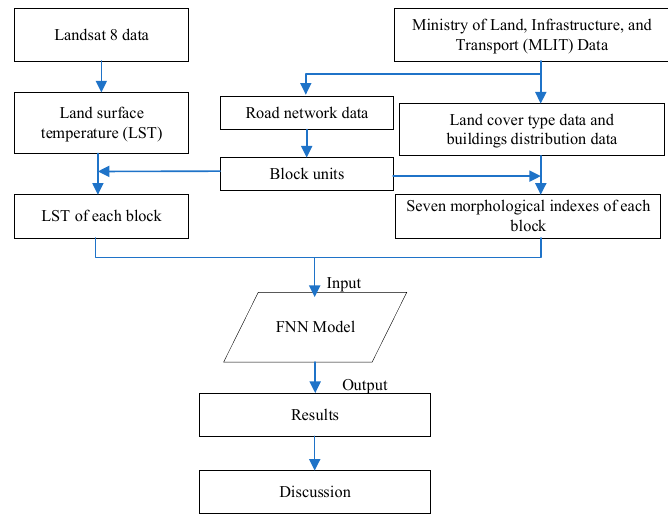
Figure 1. The flow chart of study .